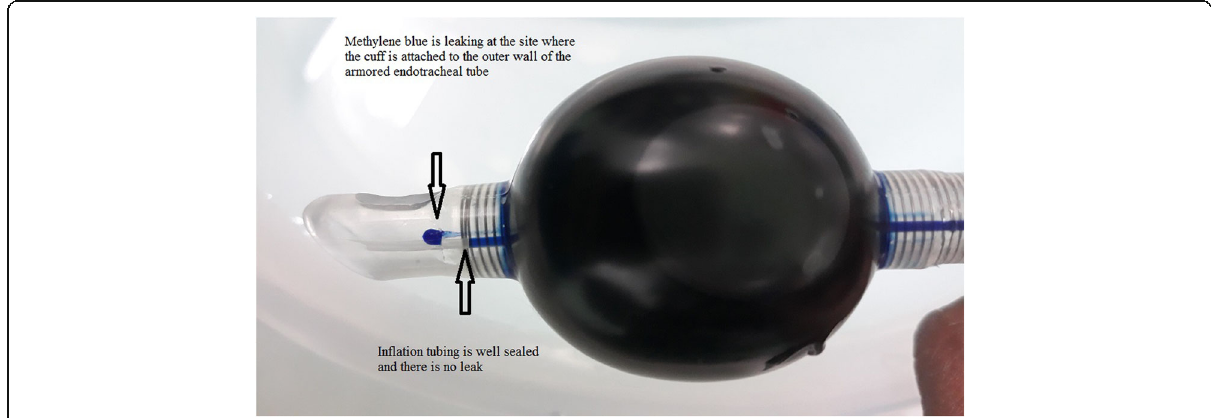
Fig. 1 Micro leak of the cuff inflation system of an armored endotracheal tube: an unreported site. The methylene blue injected through the cuff inflation system revealed a micro leak, where the cuff is attached to the outer wall of the cAETT. The other parts of the inflation system were perfectly sealed and there was no